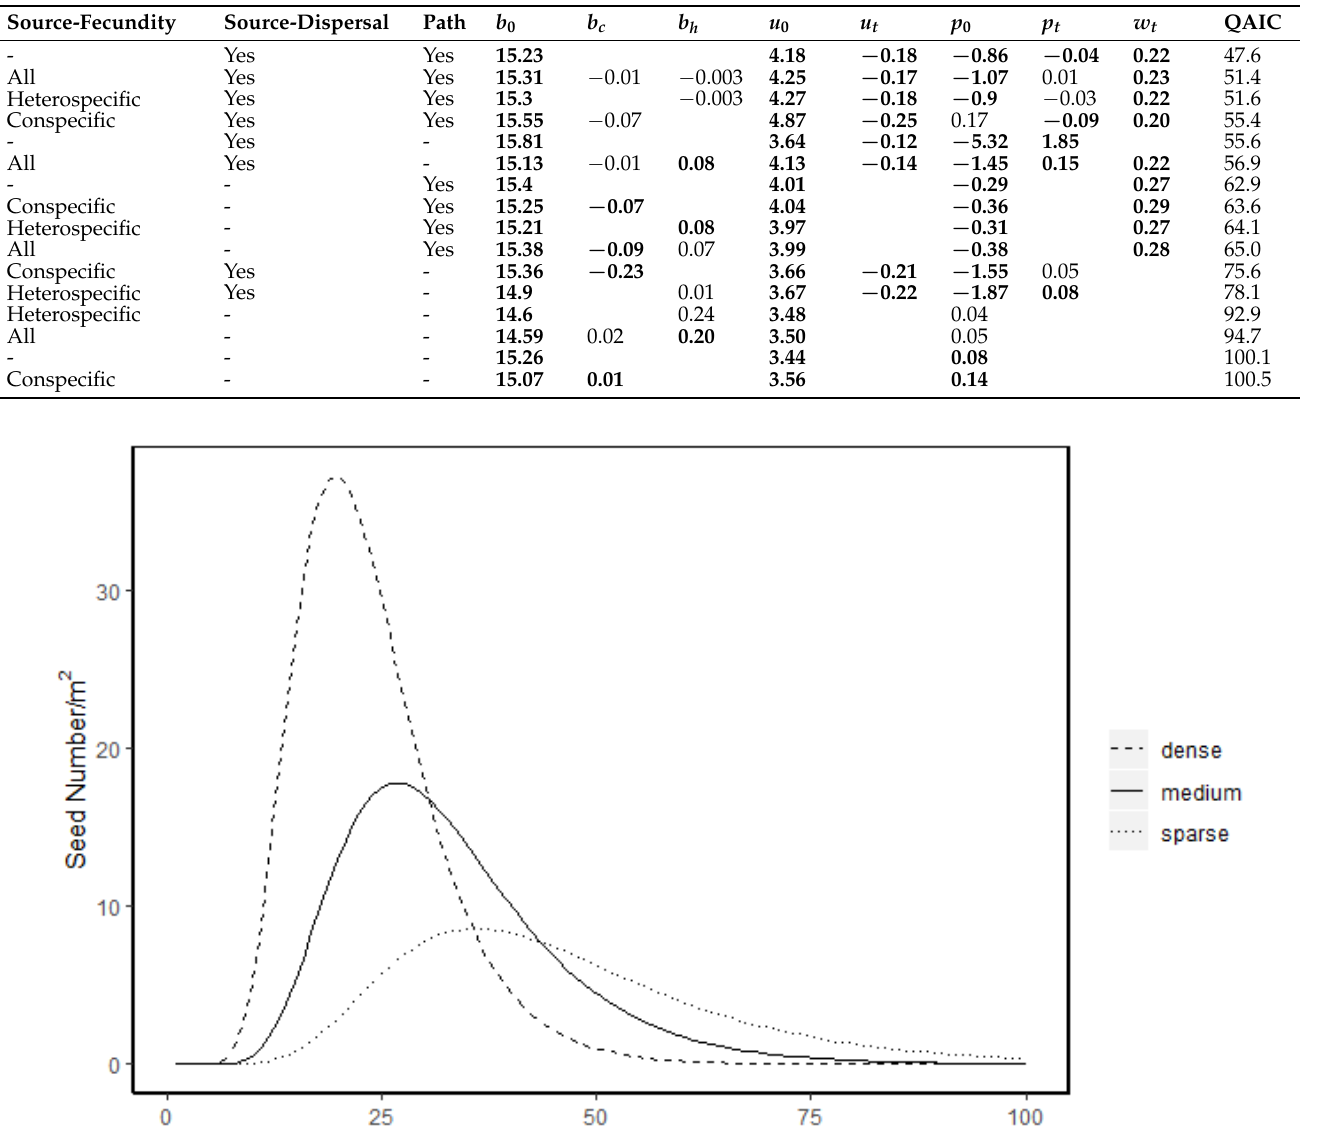
Table 1. Parameter estimations and QAIC values of all 16 models ranked according to increasing QAIC. Parameters with 95% CI that did not include zero were marked in bold.